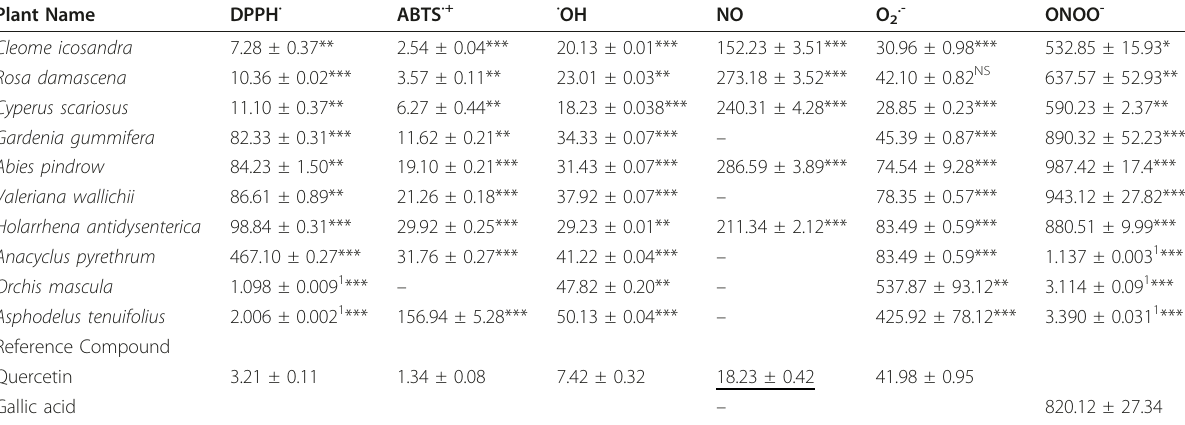
Table 3 IC50 values of plant extracts ( μ